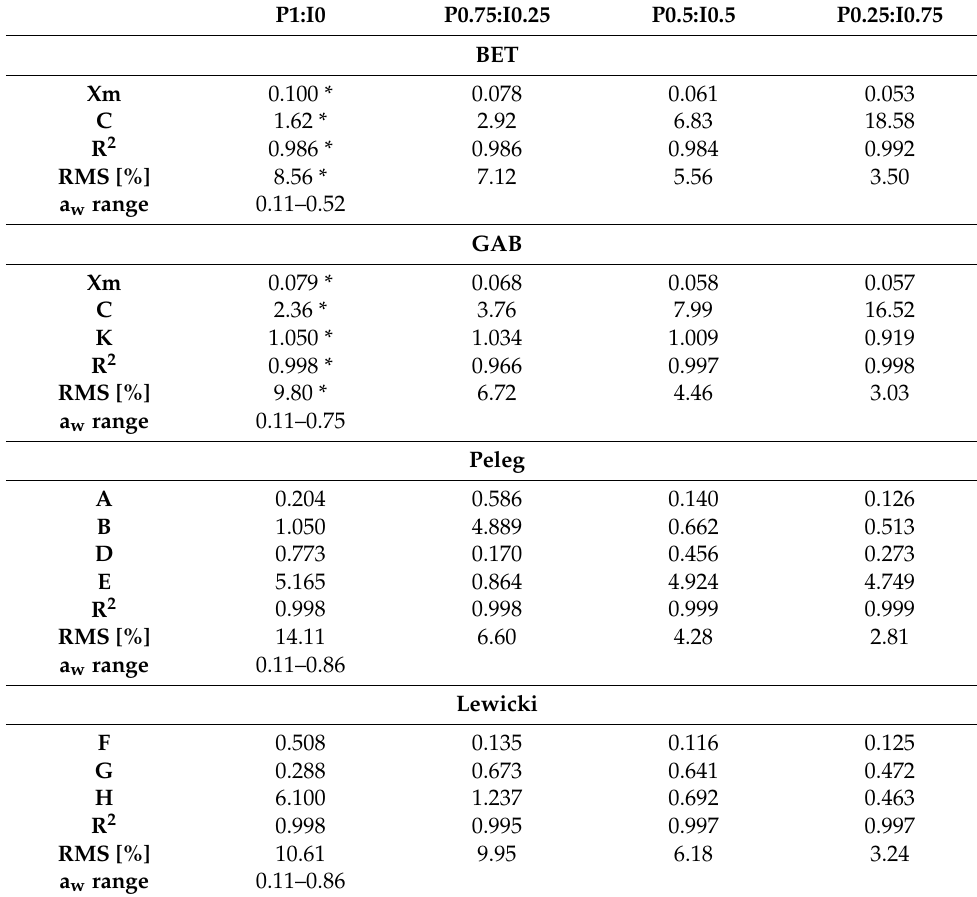
Table 1. Parameters of sorption models fitted to experimental data of the pumpkin–inulin